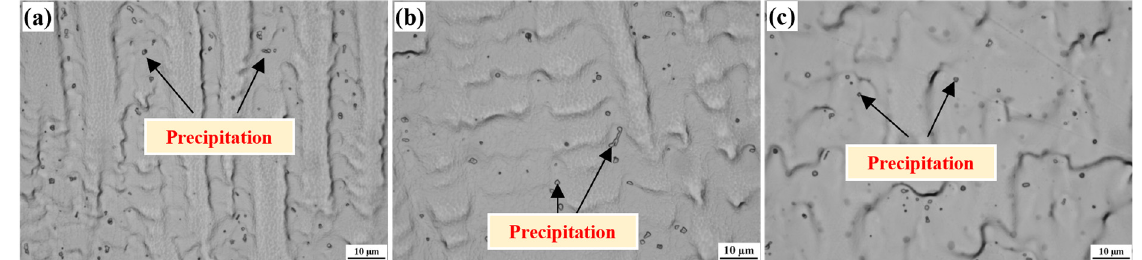
Figure 9. Distribution of precipitates of as-deposited samples with different heat inputs: ( a ) 276 J/mm, ( b ) 552 J/mm and ( c ) 828 J/mm. ( b ) 552 J/mm and ( c ) 828